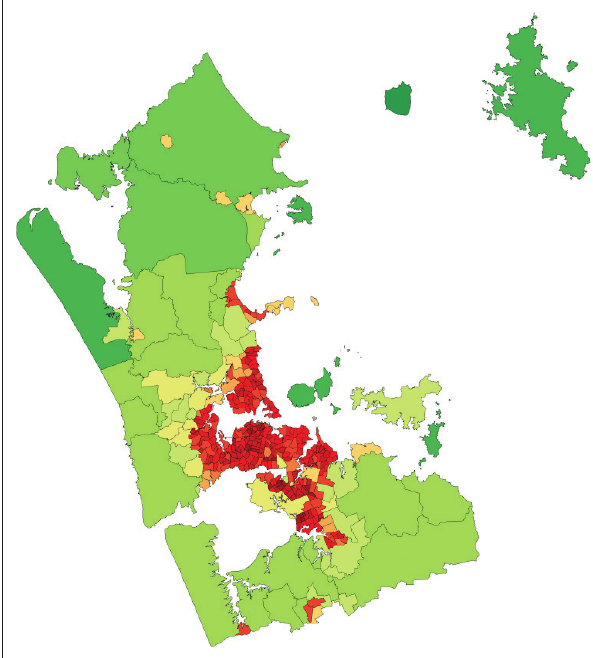
FIGURE 1: Map of